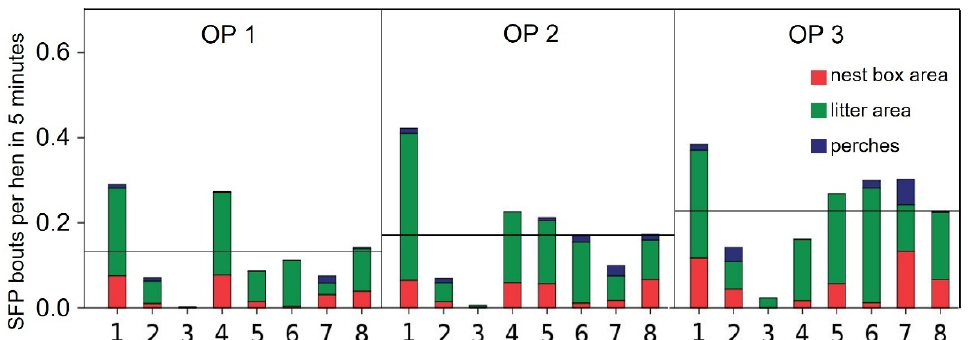
Figure 1. Mean rate of severe feather pecking (SFP) in non-beak-trimmed laying hens on flock level (Flocks 1–8). Observation Period (OP) 1: 28th to 33rd week of life; OP 2: 42nd to 48th week of life; OP 3: 63rd to 68th week of life. Horizontal black line = mean value.